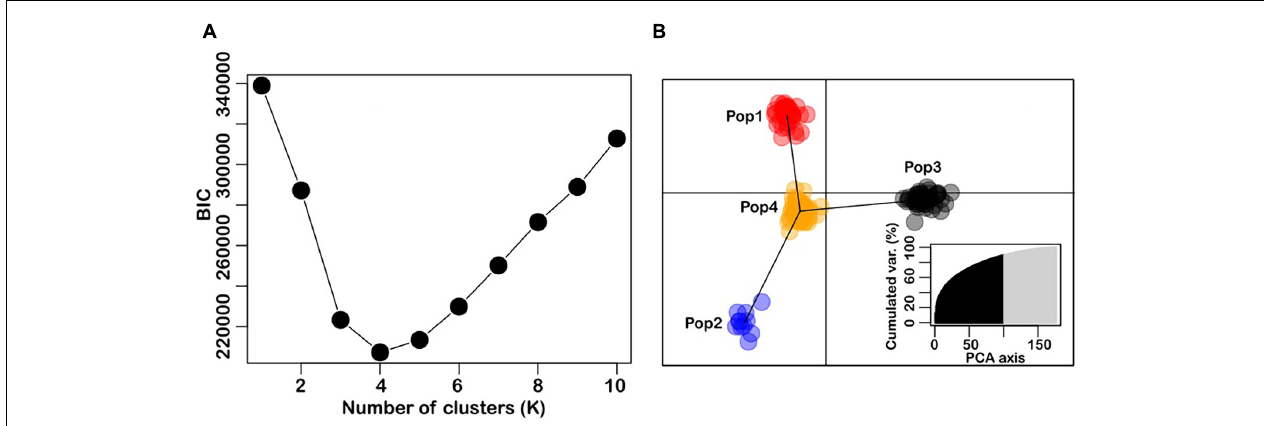
FIGURE 1 | Population structure in the panel of 177 wheat accessions used for the study. Panel (A) is the optimal number of clusters identified with the find.cluster function in adegenet (Jombart, 2008). Panel (B) is the DAPC results, showing relative positions of individuals and genetic clusters in the discriminant space (inset is the PCA eigenvalues).